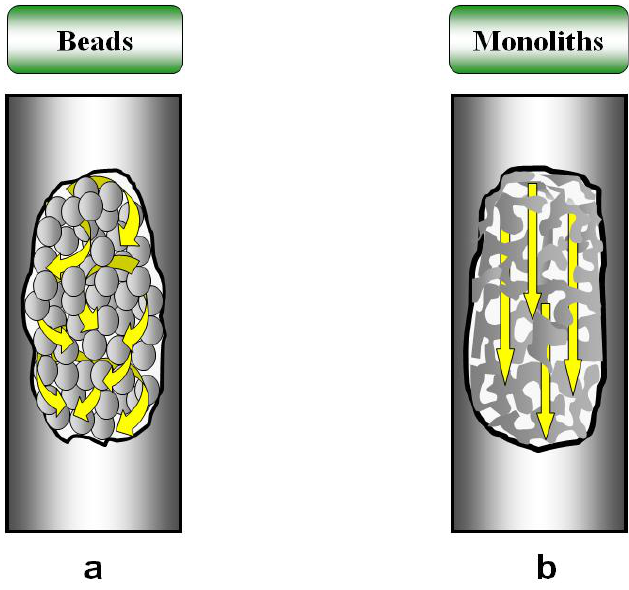
Figure 1. Passage of the mobile phase through particulate media (macroporous particles) (a) and continuous support (macroporous continuous rods)